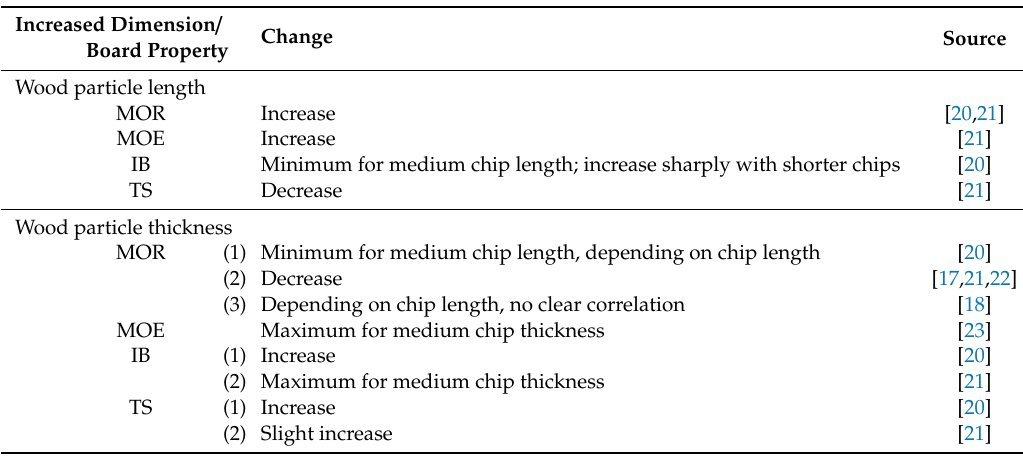
Table 1. Influence of increasing particle dimension (length or thickness) on the properties of single-layer laboratory particleboard (based on Dunky and Niemz [19]); modulus of rupture (MOR)